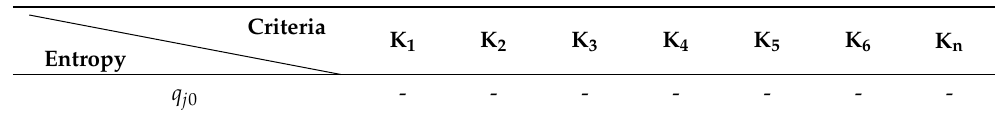
Table 12. The complex importance of criteria.